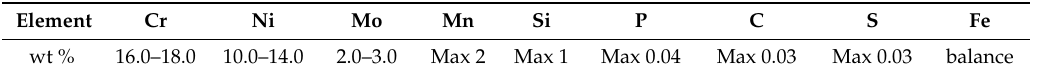
Table 1. Chemical composition of AISI 316L steel studied by Nastac et al. [15].